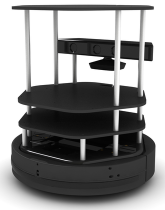
Figure 8. Turtlebot